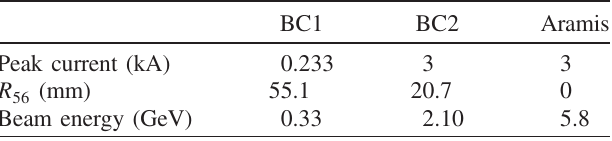
TABLE I. Beam parameters at the BC1 and BC2 exit, and at the entrance of the Aramis undulator line in SwissFEL. The bunch charge is 200 pC, the laser length 10 ps FWHM, and the peak current at the entrance of BC1 is 20 A.